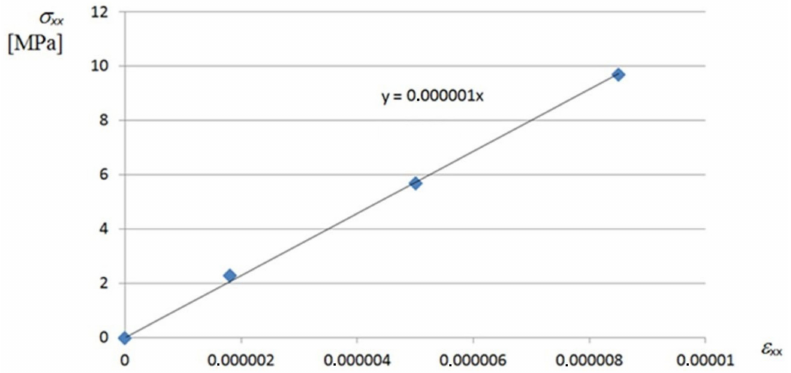
Figure A3. A linear relation between the σ xx normal stresses and corresponding ε xx strains obtained for elements located at the crosswise ends of a shell fold.